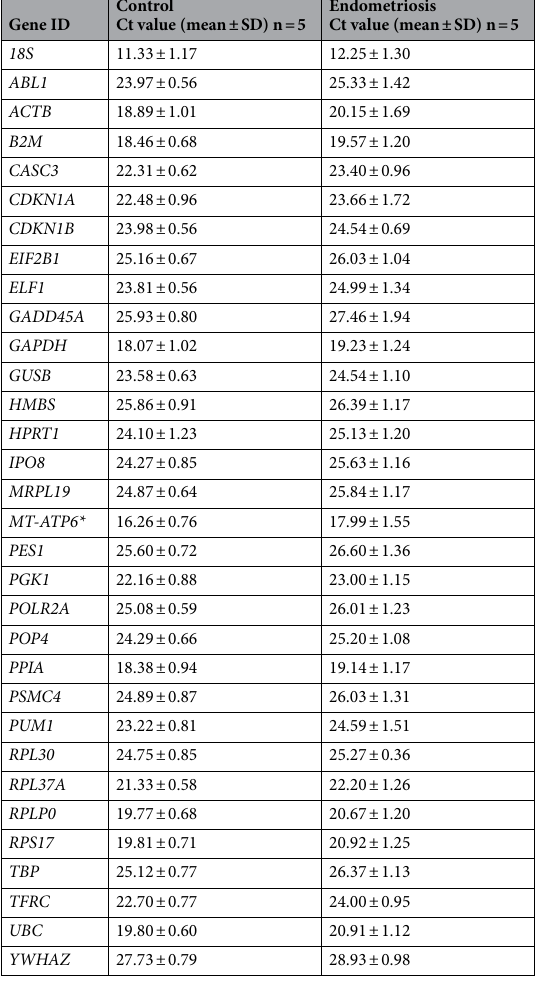
Table 1. Ct values for 32 reference genes in experimental groups. * P < 0.05. Wilcoxon rank sum test for independent